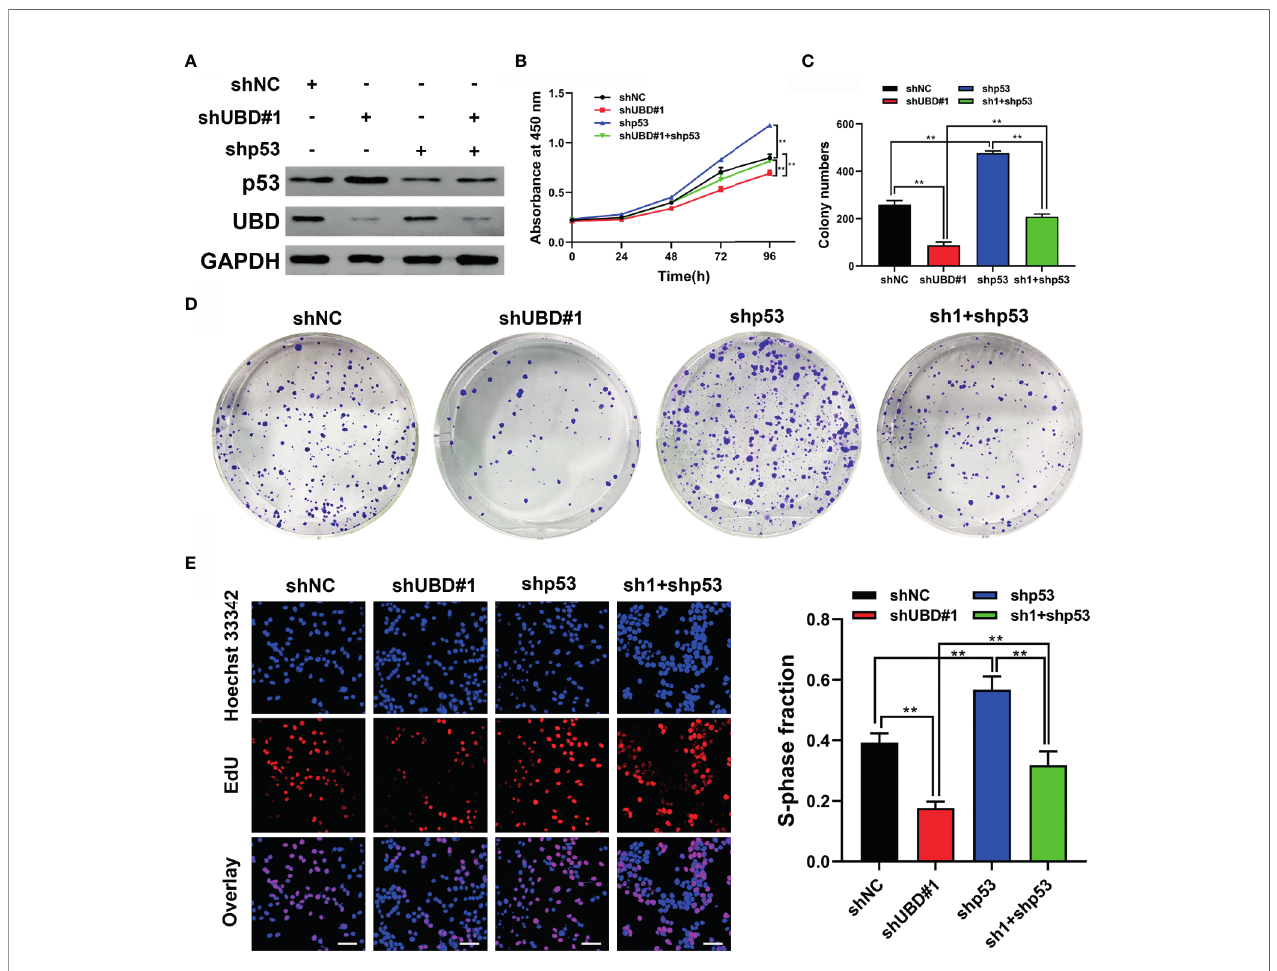
FIGURE 5 | p53 is required for UBD to regulate growth of CRC cells. (A) Western blot analysis of UBD and p53 protein expression in HCT116 cells after UBD knockdown with or without p53 knockdown. (B) Cell viability of shp53 and shUBD#1 co-transfection in HCT116 cells evaluated by CCK-8 assay (** p < 0.01). (C-E) Results of colony formation assay (C, D) and EdU assays (E) showing the proliferation of CRC cells stably transfected with shUBD#1 in the presence or absence of shp53 (E) , magni fi cation, 400×; scale bar, 100 m m). Quantitative results of colony numbers and EdU positive cells are presented in data graphs (** p < 0.01). sh1,